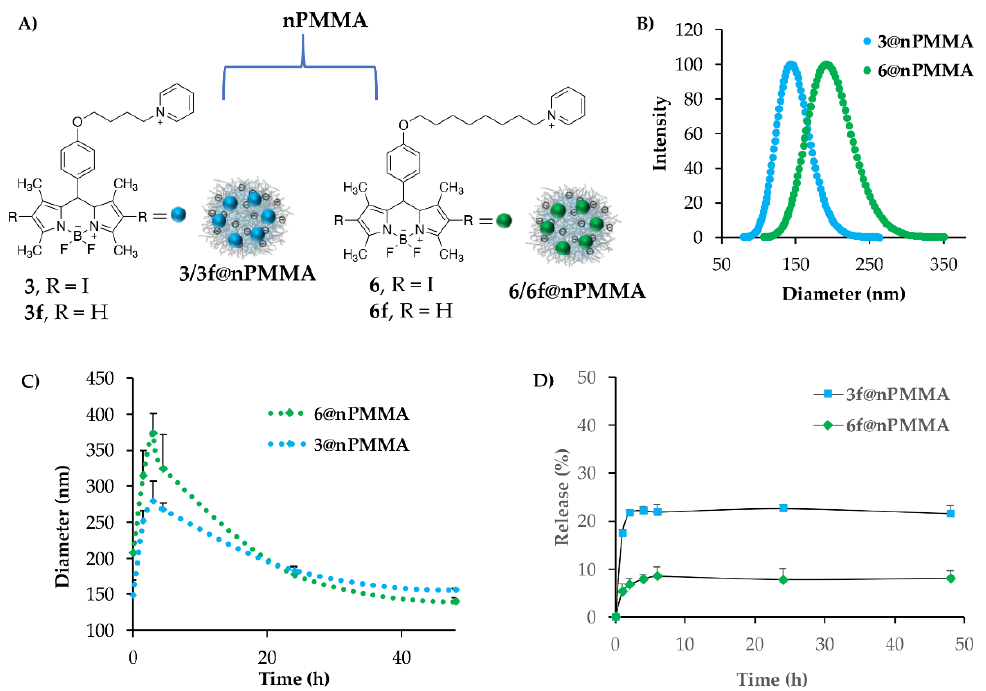
Figure 2. ( A ) Schematic representation of 3/3f@nPMMA and 6/6f@nPMMA nanoparticles. ( B ) Representative DLS measurements of 3@nPMMA (blue circles) and 6@nPMMA (green circles) nanoparticles. ( C ) Particle size stability of 3@nPMMA (blue circles) and 6@nPMMA (green circles) nanoparticles in FBS 20% in PBS pH 7.4, v / v , as determined by DLS analysis. ( D ) Release profiles of 3f and